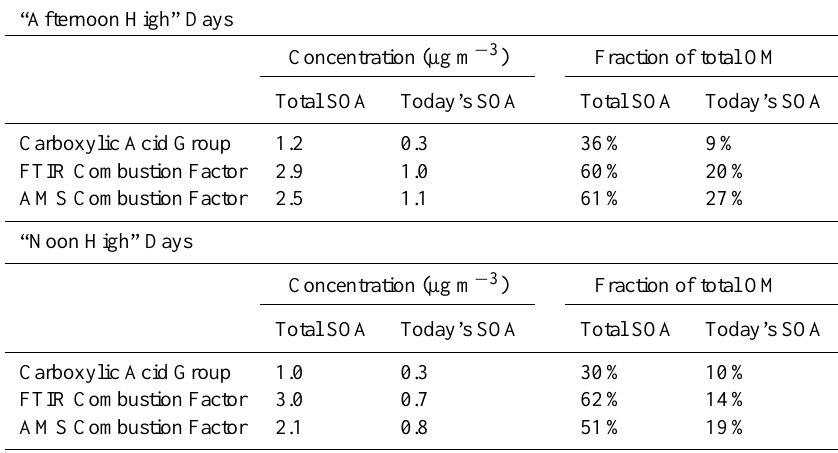
Table 3. Mass concentration and OM fraction of “Total SOA” (estimated from the “chemical-composition” based method) and “Today’s SOA” (estimated from the “pseudo-Lagrangian” based method) calculated from carboxylic acid groups, the FTIR combustion factor, and the AMS combustion factor for the “Afternoon High” and the “Noon High” days.